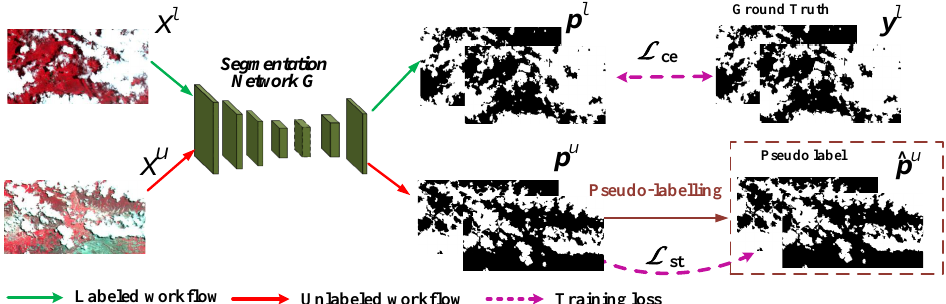
Figure 1. The traditional semi-supervised segmentation